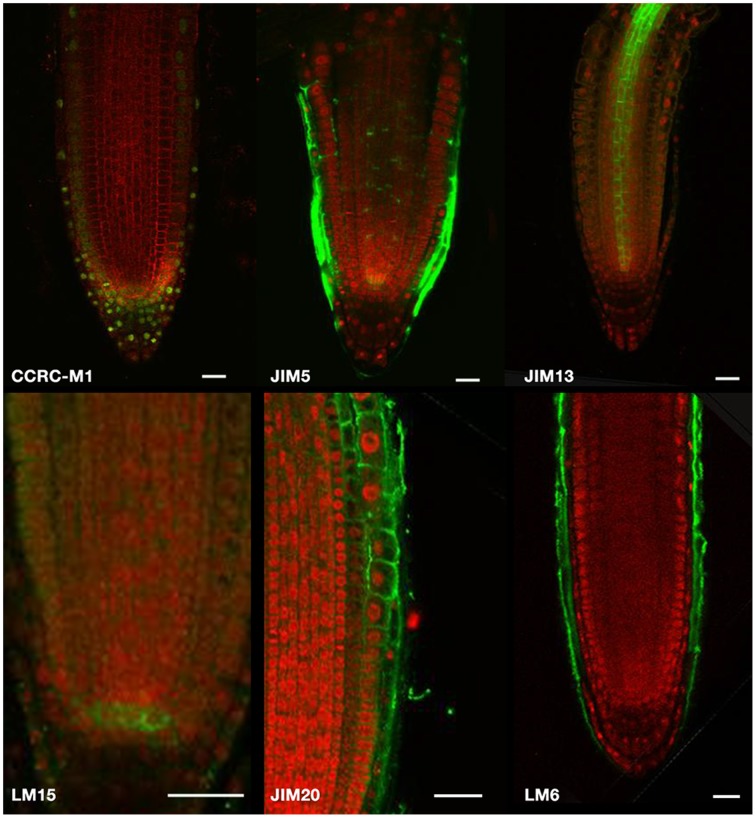
Immunolocalization with key antibodies. CCRC-M1 and LM15 detect xyloglucans, JIM5 detects pectins, JIM20 detects extensins, and JIM13 and LM6 bind to AGPs. An AF488-linked secondary antibody was used for all antibodies except CCRC-M1 for which an AF543-linked antibody was used. The scale bars correspond to 100 μm for all images except LM15 for which it is 25 μm.